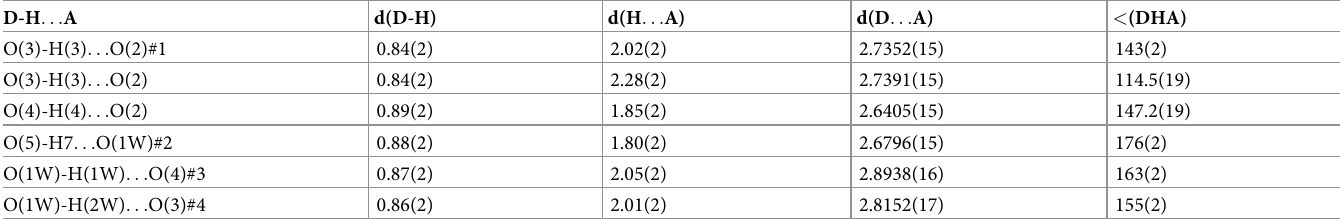
Table 2. Hydrogen bonds for galangin [ Å and